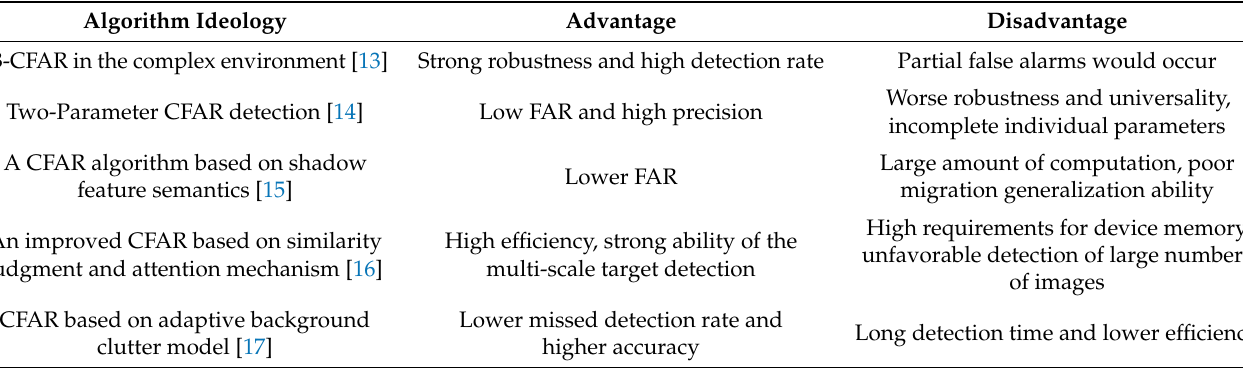
Table 2. A brief overview of the target detection algorithms based on gray